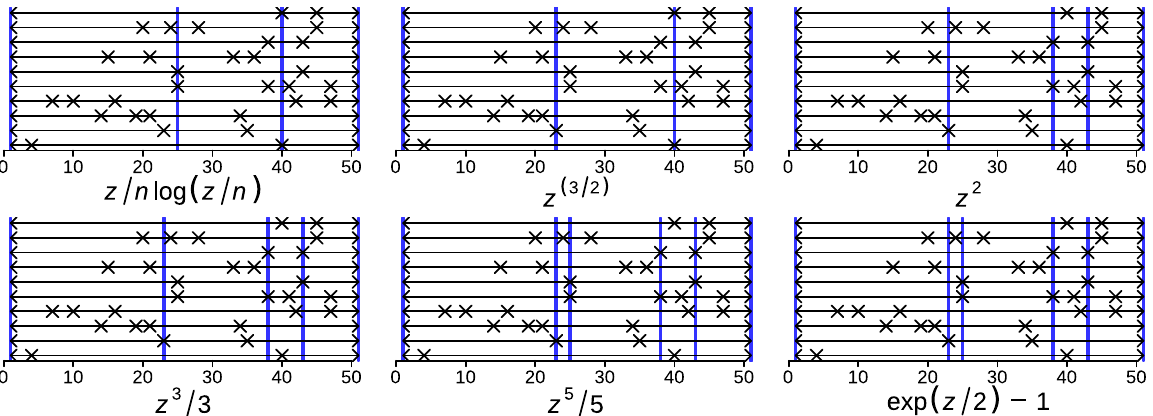
Figure 7. Consensus segmentation (shown by blue vertical lines) for a collection of 10 random segmentations with equal weights for six different potential functions e ( z ) . Note that only breakpoints of the input segmentations (marked by in the consensus